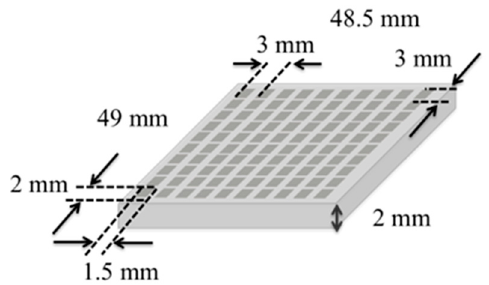
Figure 10. The experimental system for one- and two- dimensional imaging experiments.